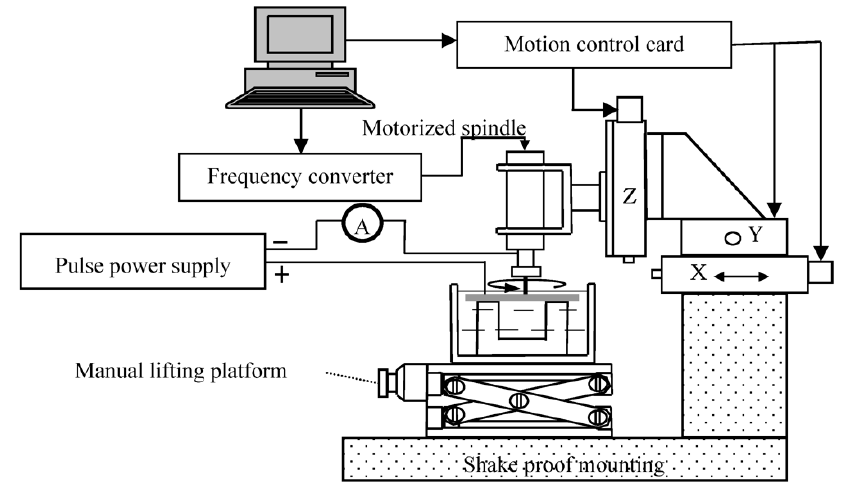
Figure 1. Schematic diagram of experimental system.